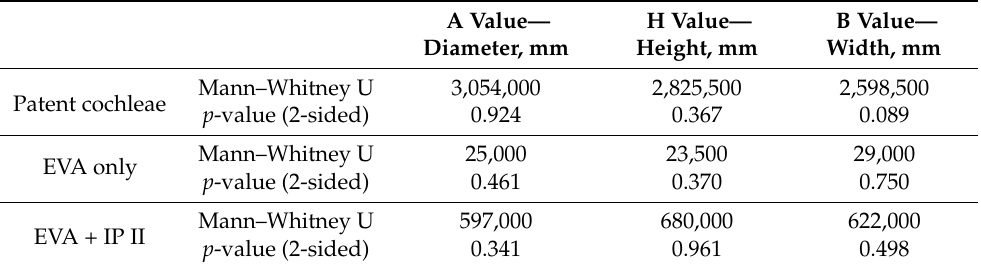
Table 2. Comparison of the cochlear parameters between the left and right ear in the groups with patent cochleae, EVA only, and EVA + IP II.